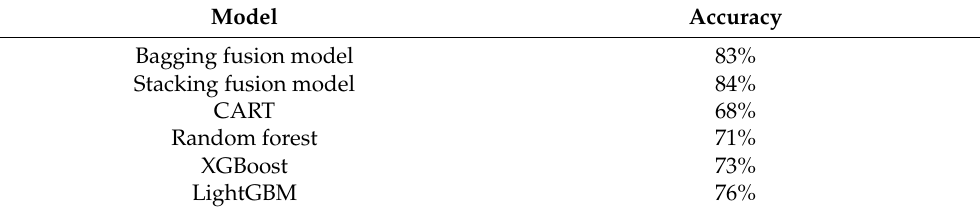
Table 3. Accuracy of fusion models and single